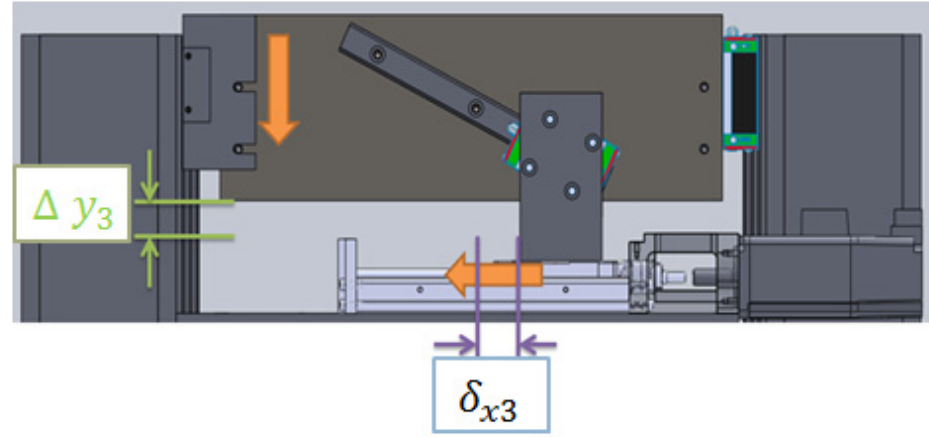
Figure 13. Ballscrew D motion along Y-axis with translation error.